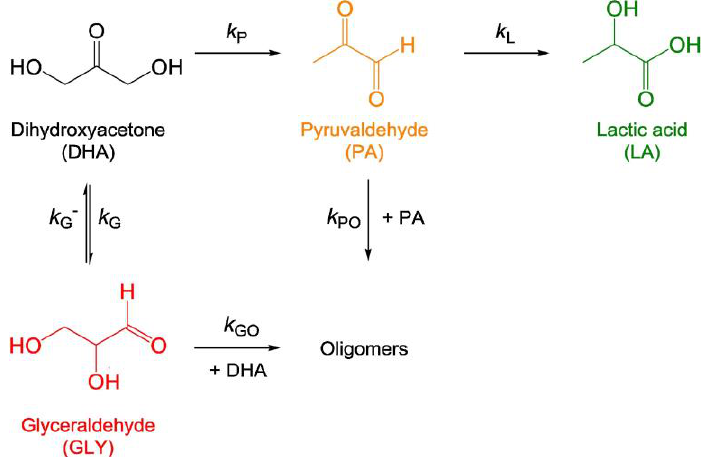
Figure 18. Conversion of dihydroxyaceonte (DHA), selectivity of products and Lewis acid/Brønsted acid ratios as a function of chromium contents in silica-supported chromium–titanium mixed oxides. Reaction conditions: Dihydroxyacetone (0.55 mmol), catalyst (50 mg), water (3 mL), 130 °C, 1.5 h. Reproduced with permission from [46]; copyright (2019), Elsevier. Catalysts 2019 , 9 , x FOR PEER REVIEW